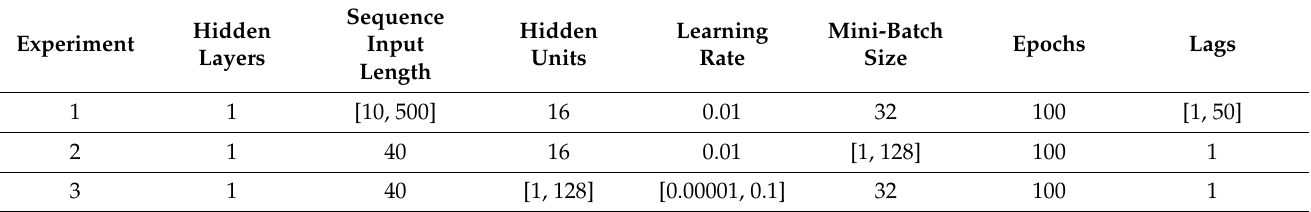
Table 2. The complete list of fixed and varying hyperparameter values for Experiments 1–3 for all the tested neural network